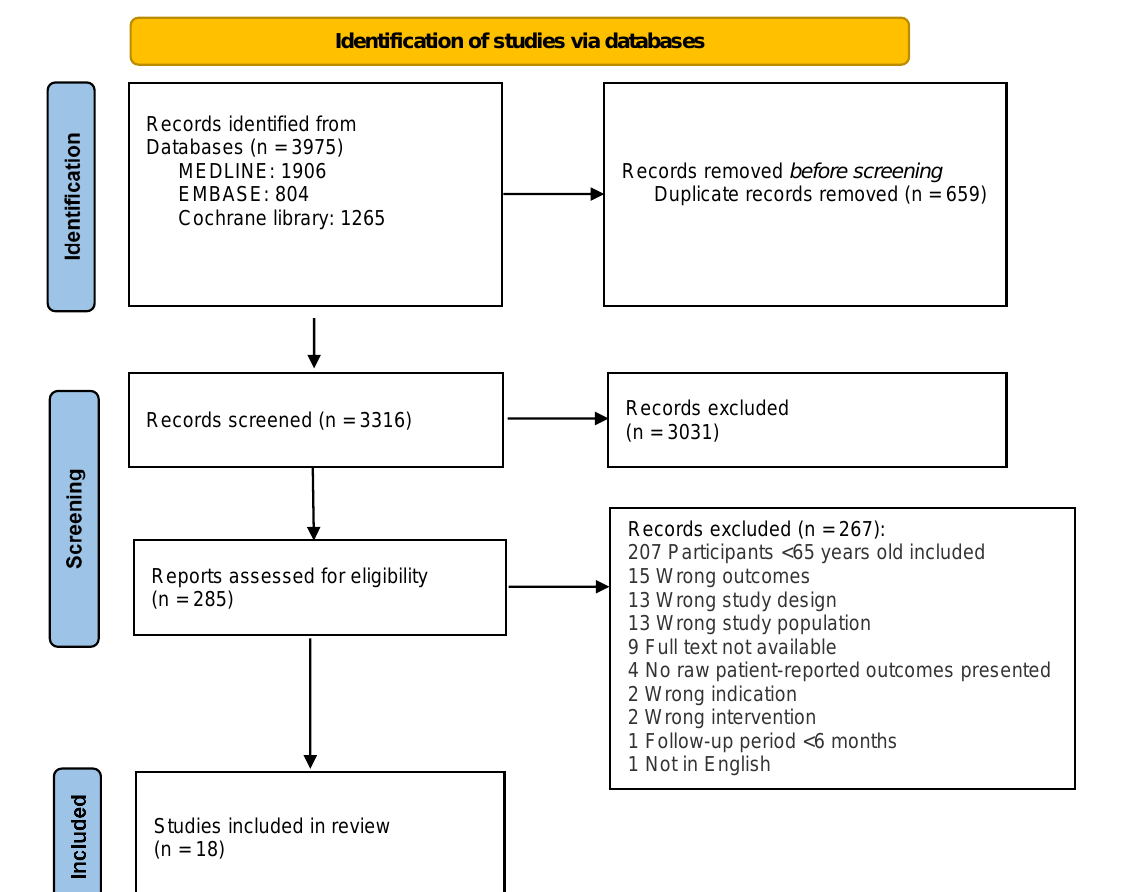
Figure 1. PRISMA flow diagram of included studies.